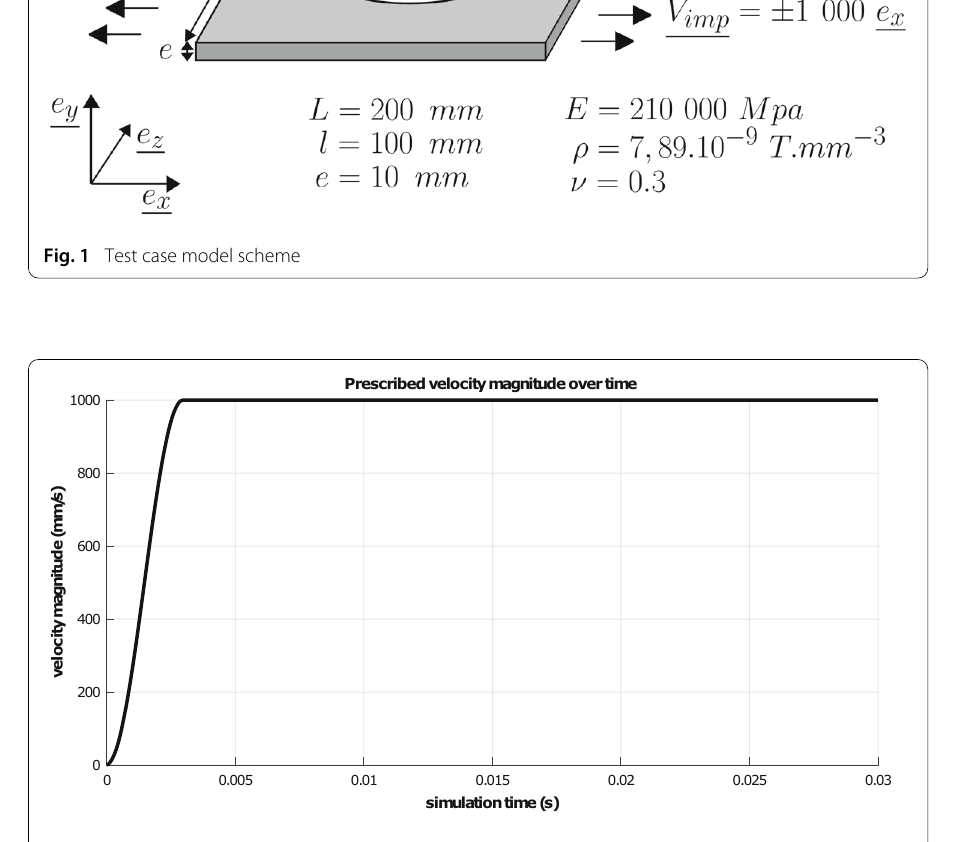
Fig. 2 Imposed velocity magnitude for the pierced